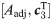
Graphs based on topology described by the adjacency matrix.(a) Graph of the network whose topology is described by the adjacency matrix (23) with a single driving node S3, and (b) the dual graph. If a32 vanishes in (b), nodes S1 and S2 become non-accessible and the dual network is no longer structurally controllable, hence the pair [Aadj,c3T] is no longer structurally observable from S3.